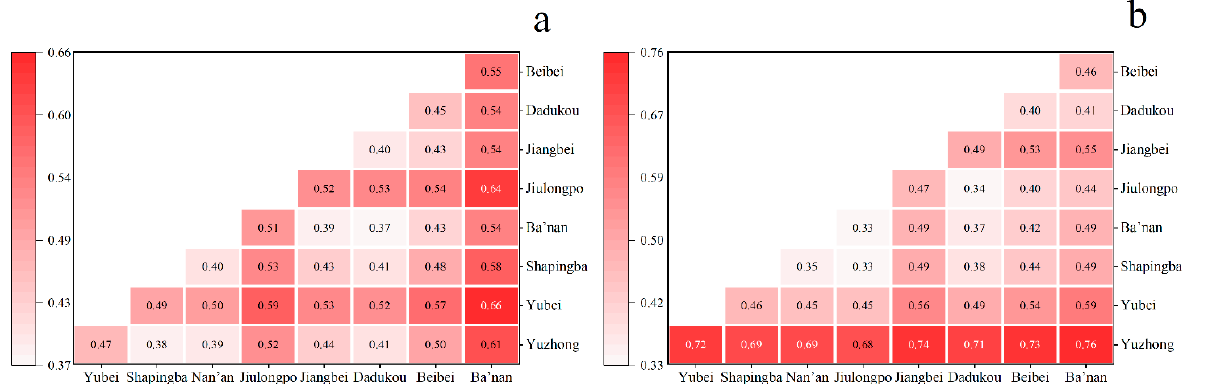
Table 4. Summary statistics for MGWR parameter estimates.